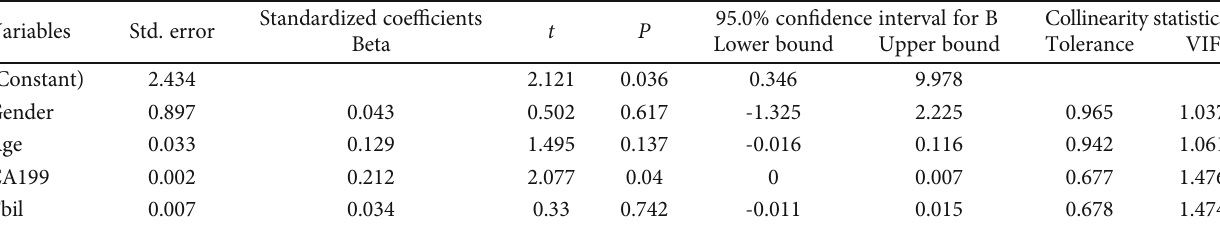
Table 5: Multiple linear regression for WBC.